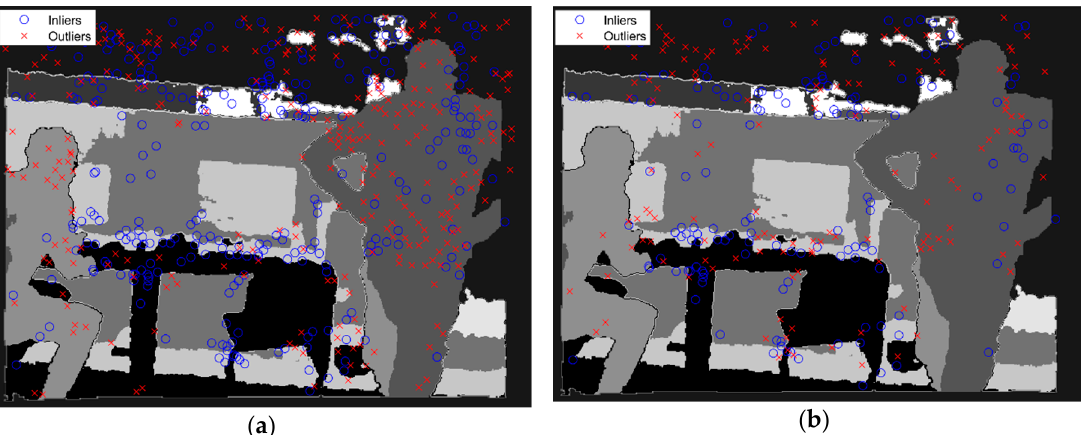
Figure 7. The third step of the moving object detection method. ( a ) The positions of the inliers (blue circle marks) and outliers (red x marks) on the clustered depth map after the first fundamental matrix constraint; ( b ) the positions of the inliers (blue circle marks) and outliers (red x marks) on the clustered depth map after the second fundamental matrix constraint. Different gray values represent different cluster areas.